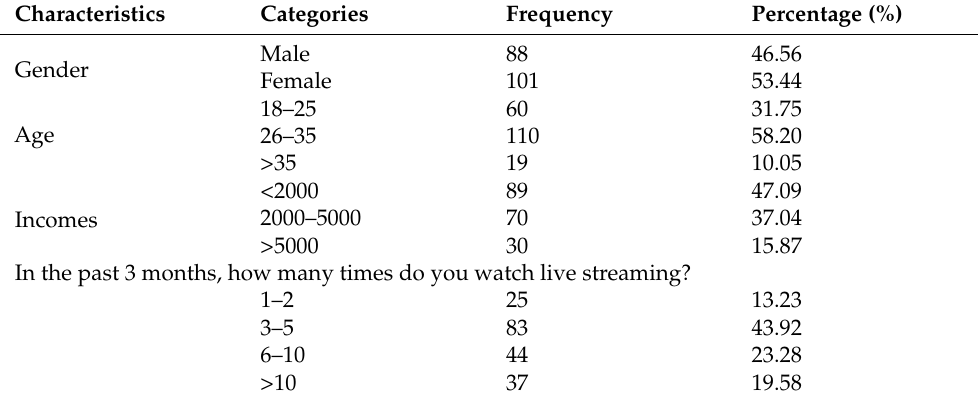
Table 2. Demographic information of